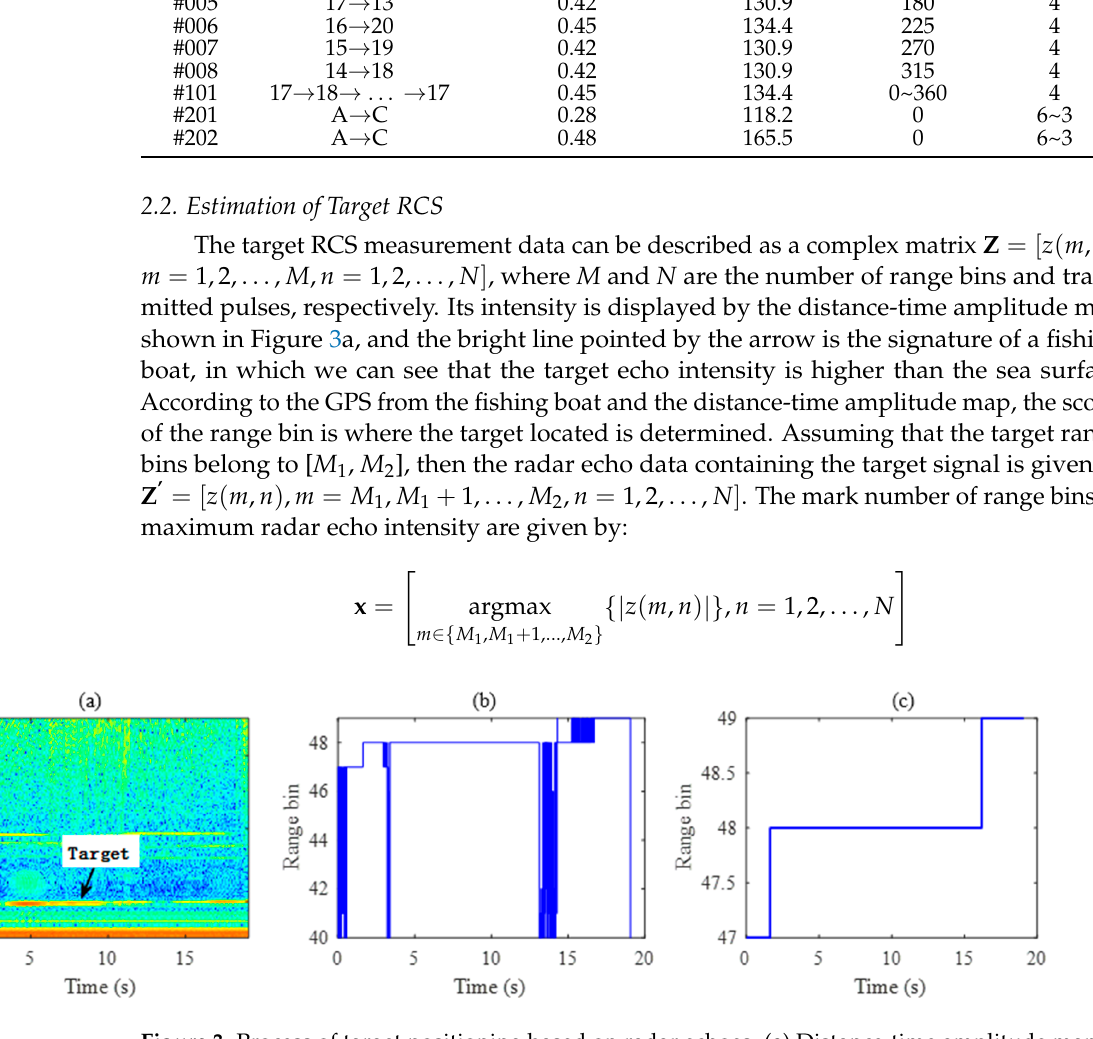
Figure 3. Process of target positioning based on radar echoes. ( a ) Distance-time amplitude map of radar echoes; ( b ) target range bin, with maximum radar echo intensity around the target; ( c ) modified target range bin by two-stage median filter.